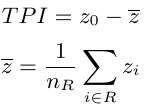
Table 2: Description of Stock Data attributes